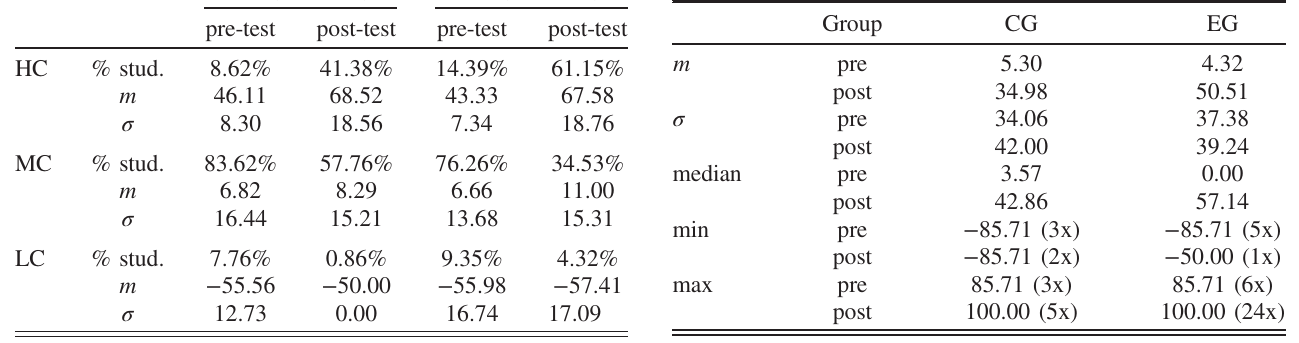
TABLE IX. Descriptive statistics on the conception indices for